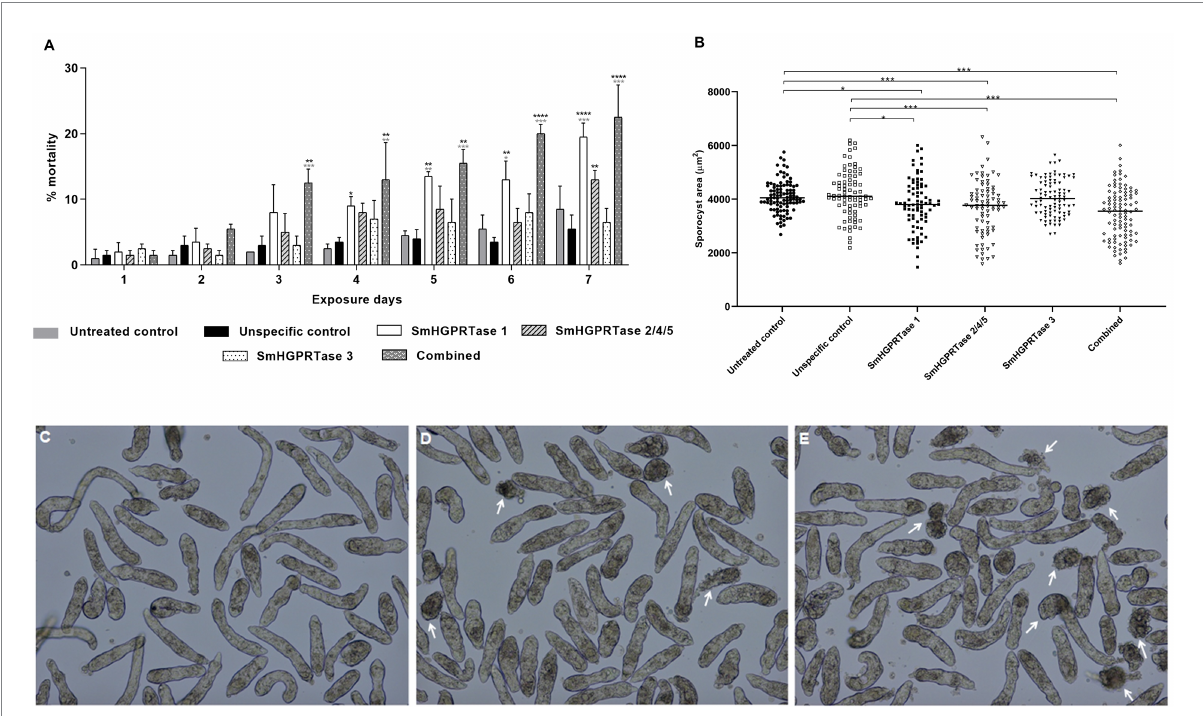
FIGURE 6 Viability of sporocysts exposed to SmHGPRTases -dsRNAs. (A) Bars representing the mortality percentage of sporocysts exposed to specific dsRNAs and control groups as described in the legend. Above the bars are represented the standard error of the mean of two biological replicates. As the statistical test, Two-way ANOVA with Sidak’s multiple comparisons was used. Black asterisks represent significant differences from untreated control and gray asterisks from unspecific controls. (B) Area ( μ m 2 ) of sporocysts exposed to the SmHGPRTases-dsRNAs. Symbols represent a single parasite for each experimental group. Black circles, untreated control; White squares, unspecific control; Black square, parasites exposed to SmHGPRTase 1 -dsRNA; White triangles, parasites exposed to SmHGPRTase 2/4/5 -dsRNA; Black triangles, parasites exposed to SmHGPRTase 3 -dsRNA; White rhombus, combined group. The horizontal black lines represent the median area of the sample population. After verifying the normality using the D’Agostino-Pearson test, significant differences compared to control conditions were analyzed by unpaired t - test. (C–E) Representative images of the untreated control group (C) , sporocysts exposed to SmHGPRTase 1 -dsRNA (D) , and sporocyst from the combined group (E) 7 days after dsRNA exposure. White arrows indicate changes in phenotype or dead sporocysts (* p ≤ 0.05; ** p ≤ 0.01; *** p ≤ 0.001; **** p <